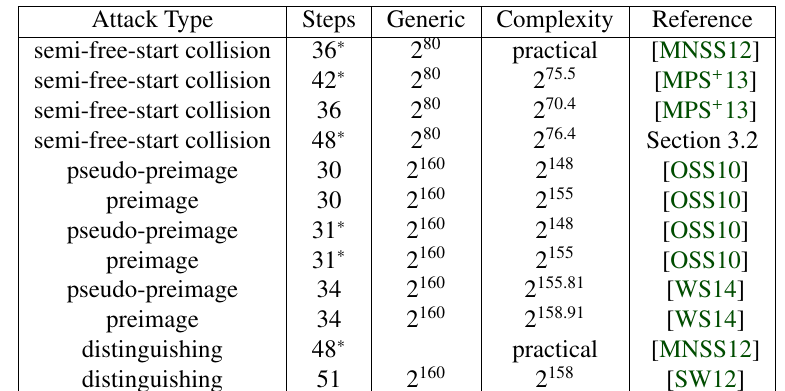
pseudo-preimage